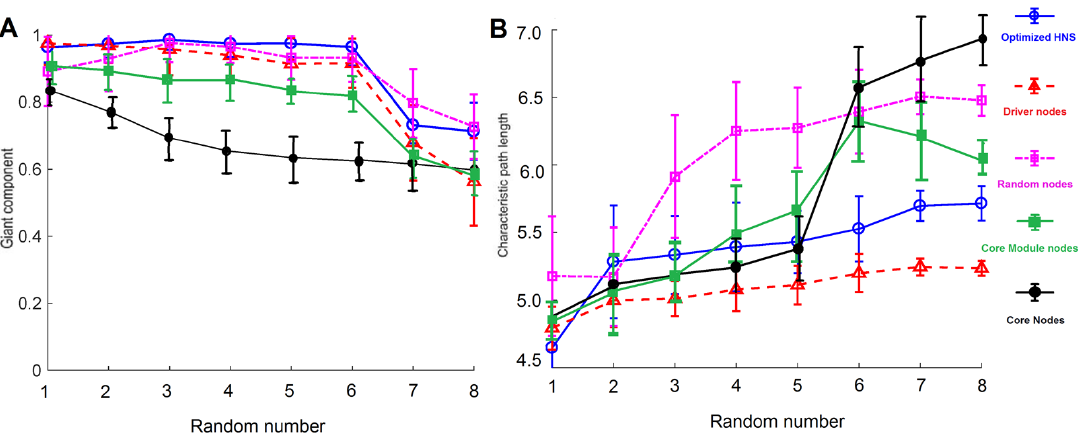
Figure 3. Performance comparisons of CM (core module), CN (core nodes), DN (driver nodes), and the OHNS of the network: ( A ) the disturbance of CM, CN, DN, OHNS, and RN on the network; the smaller the giant component, the greater the disturbance of the network; ( B ) CM, CN, DN, OHNS, and RN are important in the network; the larger the characteristic path length, the more important.